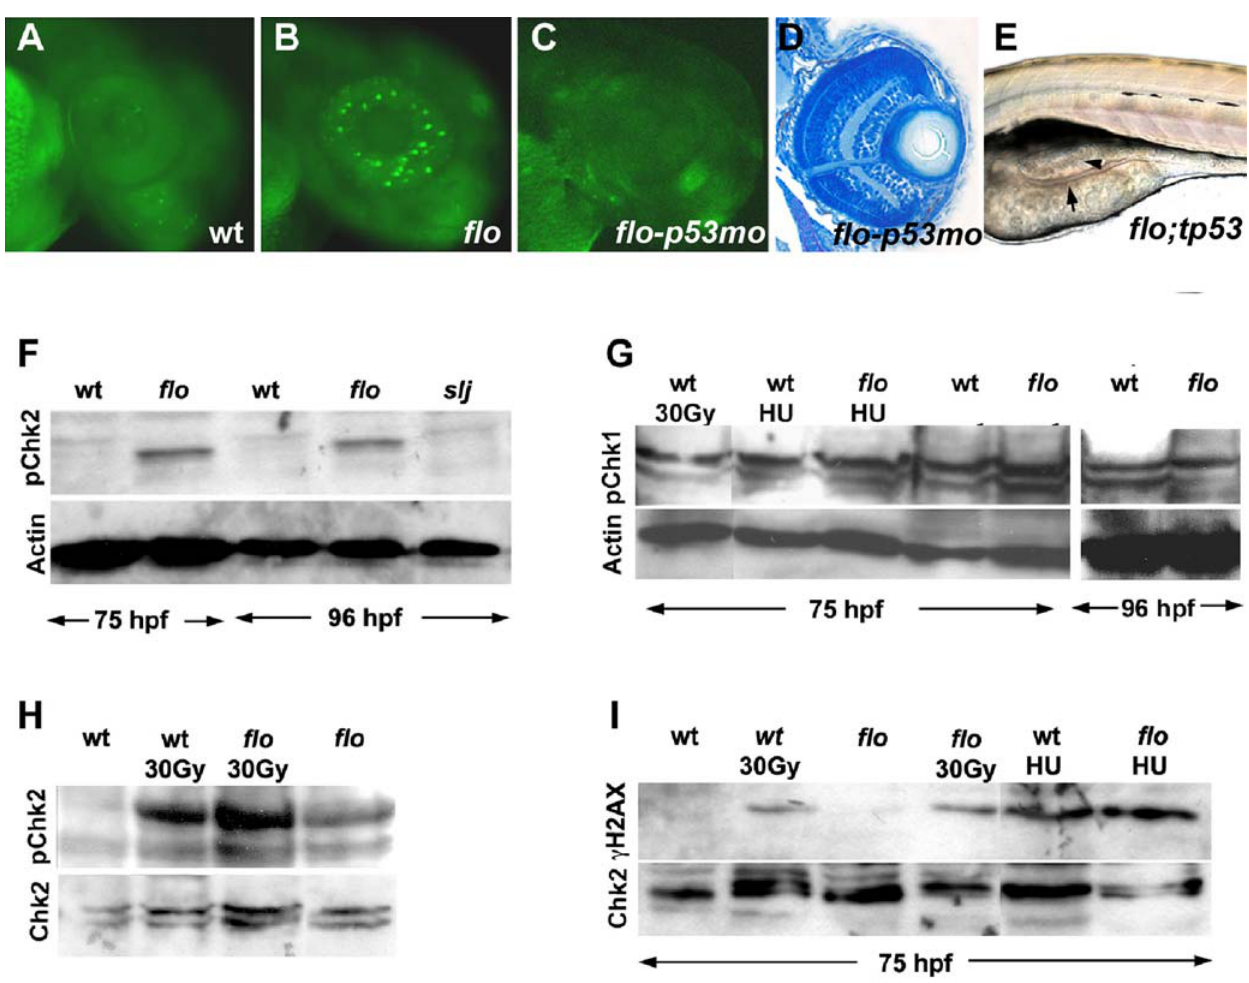
Figure 6. The flo mutation activates the DNA damage response . (A–C) Acridine orange staining showing apoptosis in the 50 hpf flo retina that is rescued by the tp53 morpholino (mo) knockdown. (D) Histological cross section showing rescue of flo retinal architecture defects by tp53 knockdown [compare (F) with Figure 1G and 1H]. (E) Intestinal defects persist in flo/tp53 double mutants. Arrow, thin intestinal wall; Arrowhead, apoptotic cells in the intestinal lumen. (F) Western blot showing elevated levels of phospho-Chk2 (Serine 33) in the intestine of flo larvae, compared with sibling wild type larvae, but not slim jim larvae (I). (G) Western blot showing comparable levels of phospho-Chk1 (Ser 345) in flo and sibling wild type larvae, before and after c -radiation (30 Gy) and treatment with hydroxyurea (HU). (H) Western blot showing enhanced phospho-Chk2 activation in the intestine of flo and wild type larvae following c -radiation (30 Gy). (I) c H2AX is not detected in the flo or wild type intestine (75 hpf), but is detected at this stage following c -irradiation (30 Gy) or hydroxyurea treatment (HU).